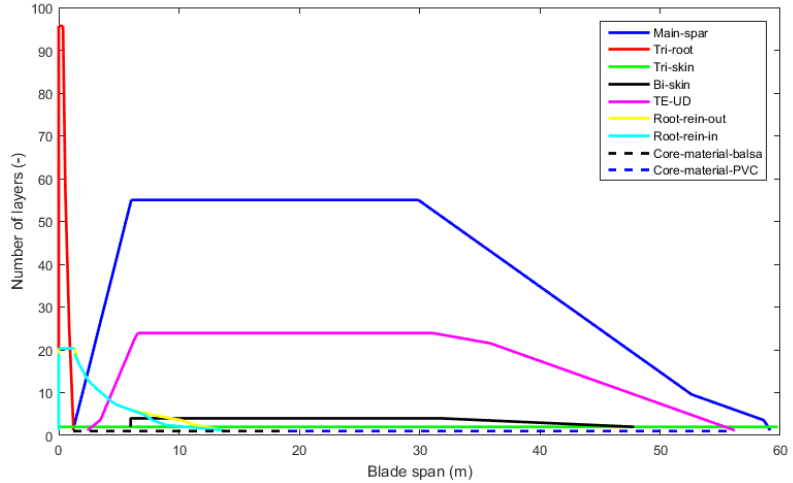
Figure 1. Distribution of section ʹ s layup layers along the blade radial coordinate.